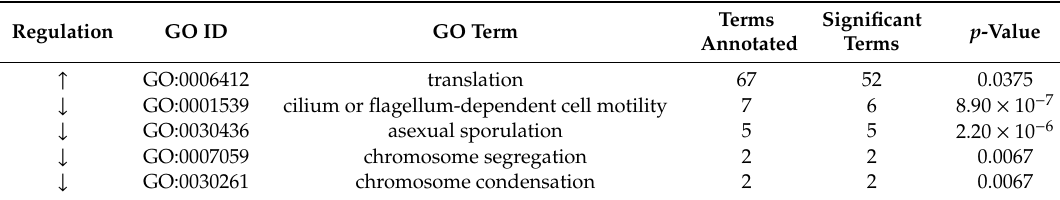
Table 2. Significantly (Fisher´s exact p -value < 0.05) enriched gene ontologies (GO) (GO = biological processes) among di ff erentially released proteins within exoproteomes of glucose and sucrose-treated cells. ↑ = increased release in sucrose, ↓ = decreased release in